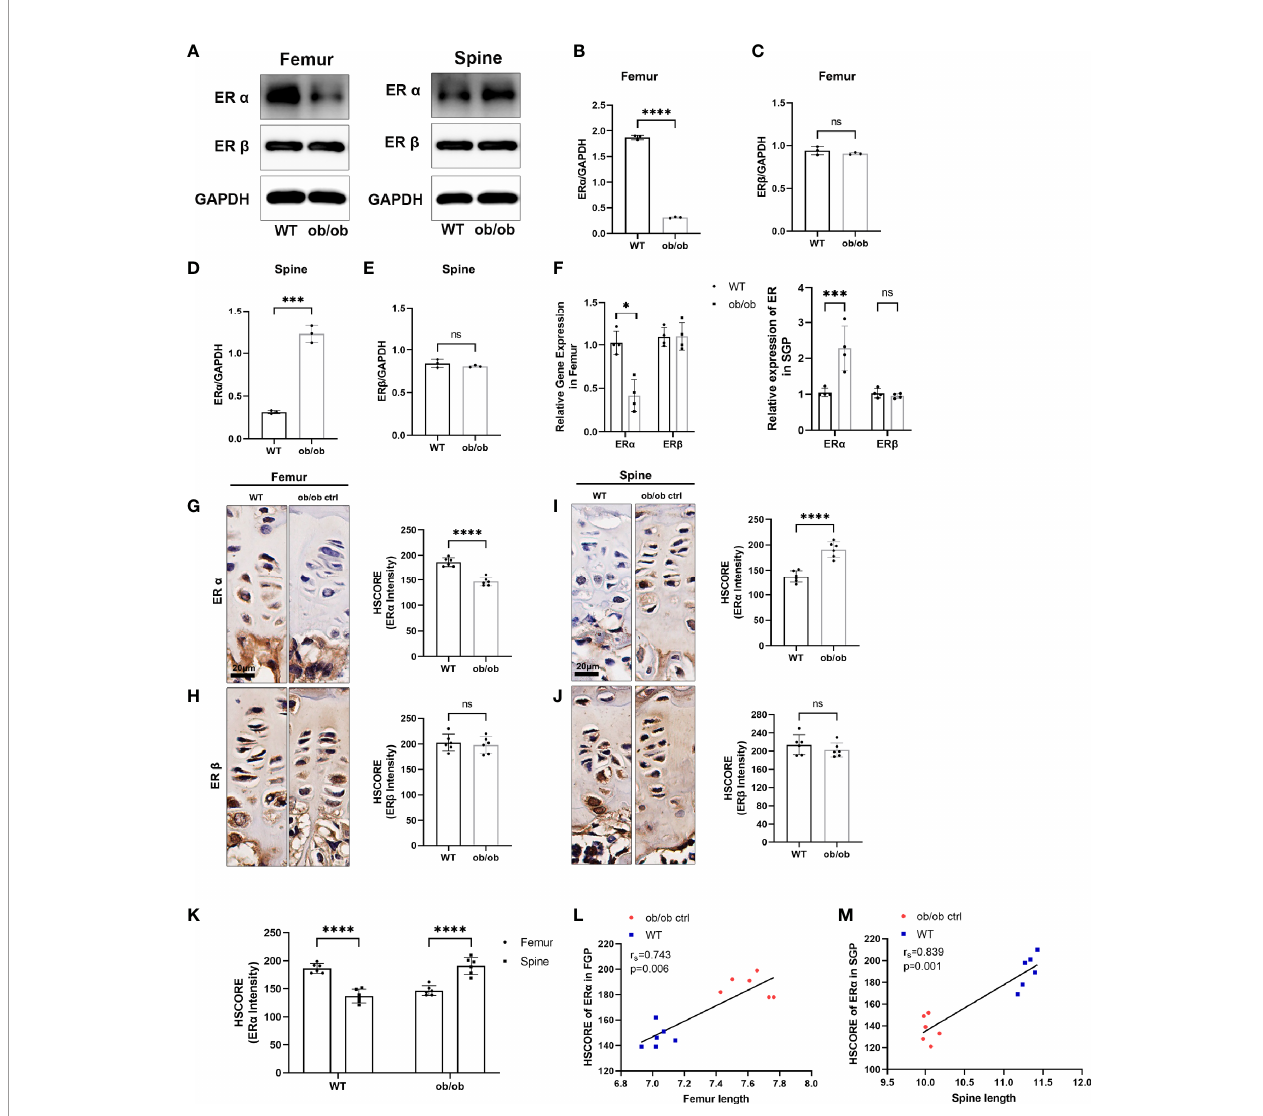
FIGURE 5 | The expression level of estrogen receptors (ERs) in femur and spine. (A) Western blotting results of expression level of ER a and ER b in femoral and spine growth plate (GP), n = 3. (B – E) Semiquantitative analysis of ER expression levels. (F) Quantitative real-time PCR results of ER genes in femoral and vertebral GP, n = 4. (G – J) Immunohistochemistry (IHC) results of expression level of ER a and ER b in femoral and vertebral GP, n = 6. Scale bar: 20 m m. (K) Comparison of ER a HSCORE between femoral and spine GP (FGP, femoral growth plate; SGP, spine growth plate). (L, M) Results of Spearman ’ s analysis between ER a HSCORE and femur/spine length. * p < 0.05, *** p < 0.001 and **** p < 0.0001; ns denotes not signi fi